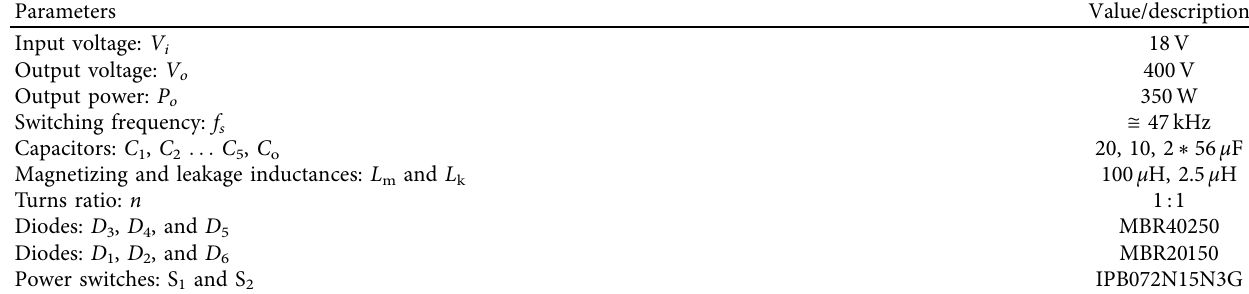
Table 3: Main specifications of the